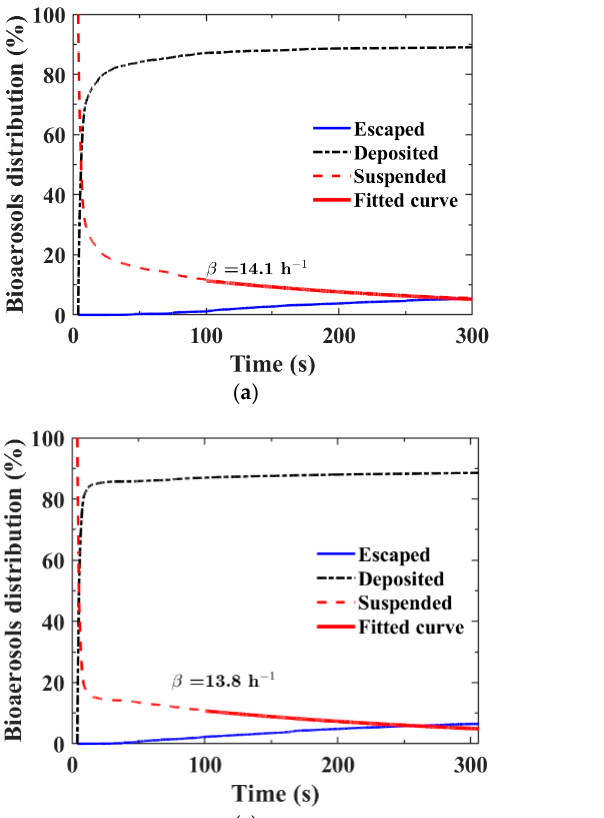
Table 1. Comparison of Case 1 and Case 2 in terms of bioaerosol fates and ventilation efficiency.